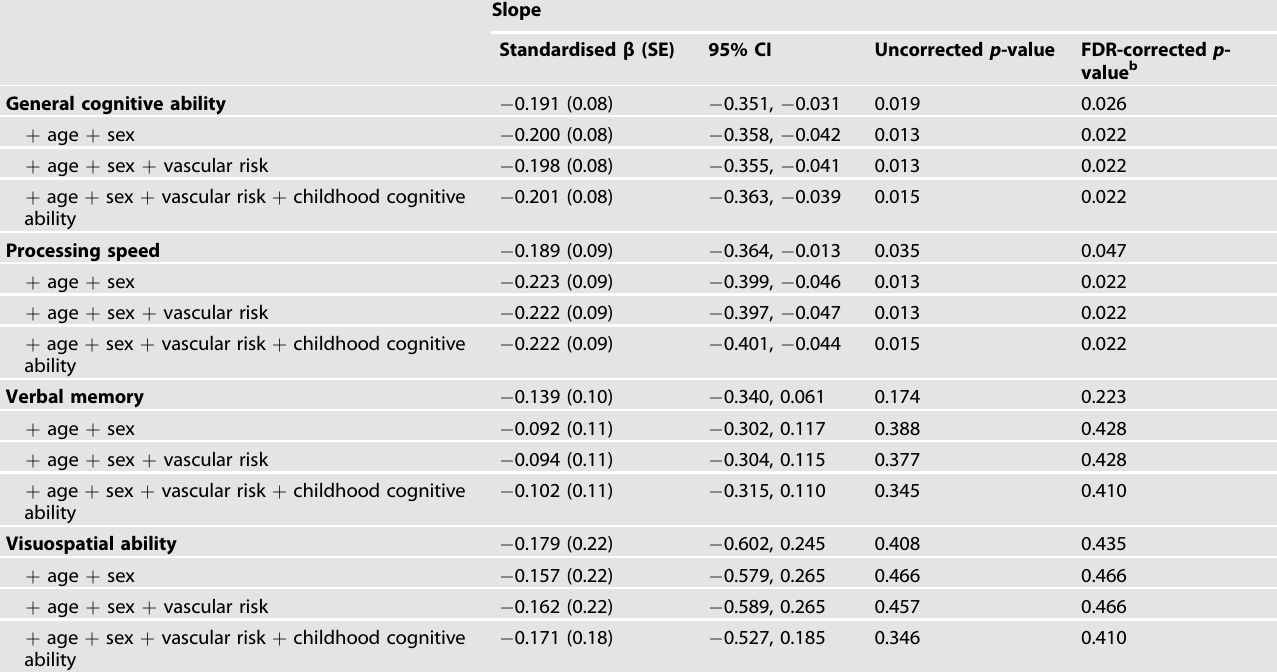
Table 3. Factor-of-curves models of associations between total SVD burden and the slope of latent cognitive variables between the ages of 73 and 82 a